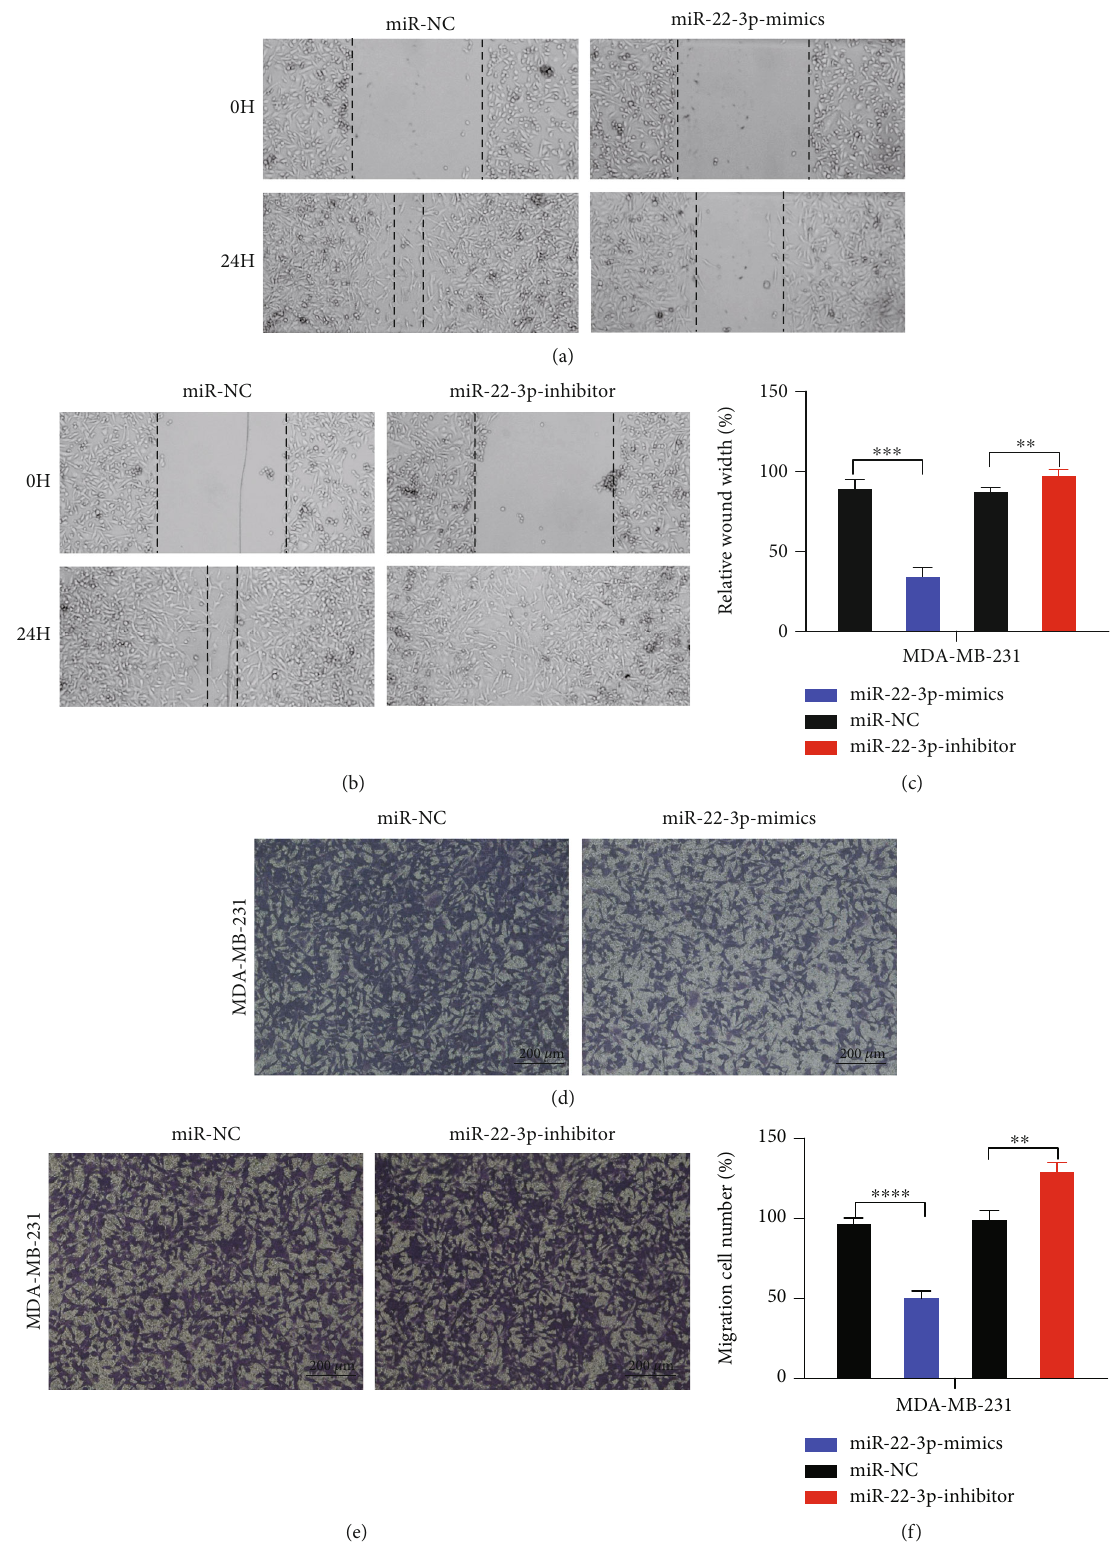
Figure 3: miR-22-3p suppressed cell migration of BC cells. (a – c) Wound healing assays were performed in MDA-MB-231 cell line treated with miR-22-3p mimics or miR-22-3p inhibitor (miR-NC as negative control). (d – f) Cell migration assays were performed in MDA-MB- 231 cell line treated with miR-22-3p mimics or miR-22-3p inhibitor (miR-NC as negative control). ∗∗ p < 0 : 01 ; ∗∗∗ p < 0 : 001 ; ∗∗∗∗ p < 0 : 0001